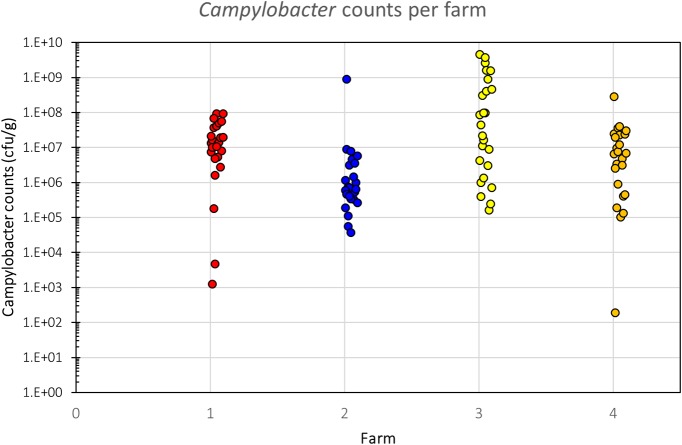
Campylobacter counts (CFU g-1) of individual birds per farm. There is a significant difference in Campylobacter counts between the farms (p = 0.00016, one-way ANOVA), despite considerable intra-farm variability.